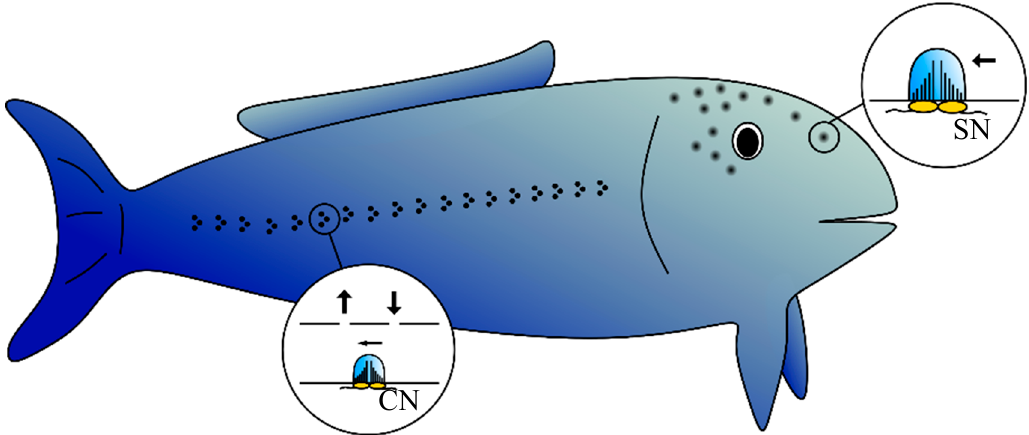
Figure 1. Neuromasts are distributed across the body of the fish, while the exact placement varies between species. Superficial neuromasts (SN) are located on the surface of the skin, while canal neuromasts (CN) are found in a canal beneath the skin that is connected to the environment via pores.